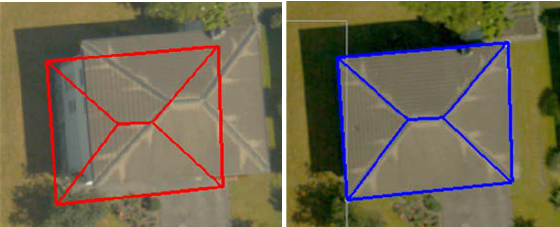
Figure 8. Building and vector plot in orthoimage (left) and true orthoimage (right).